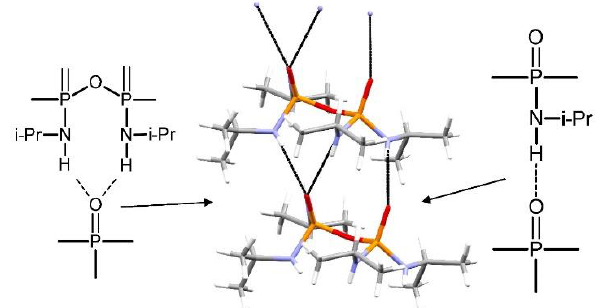
Figure 10. Hydrogen bonding synthons present in the structure of O(( i PrNH) 2 PO) 2 (generated in Mercury [25] and ChemSketch [24]).